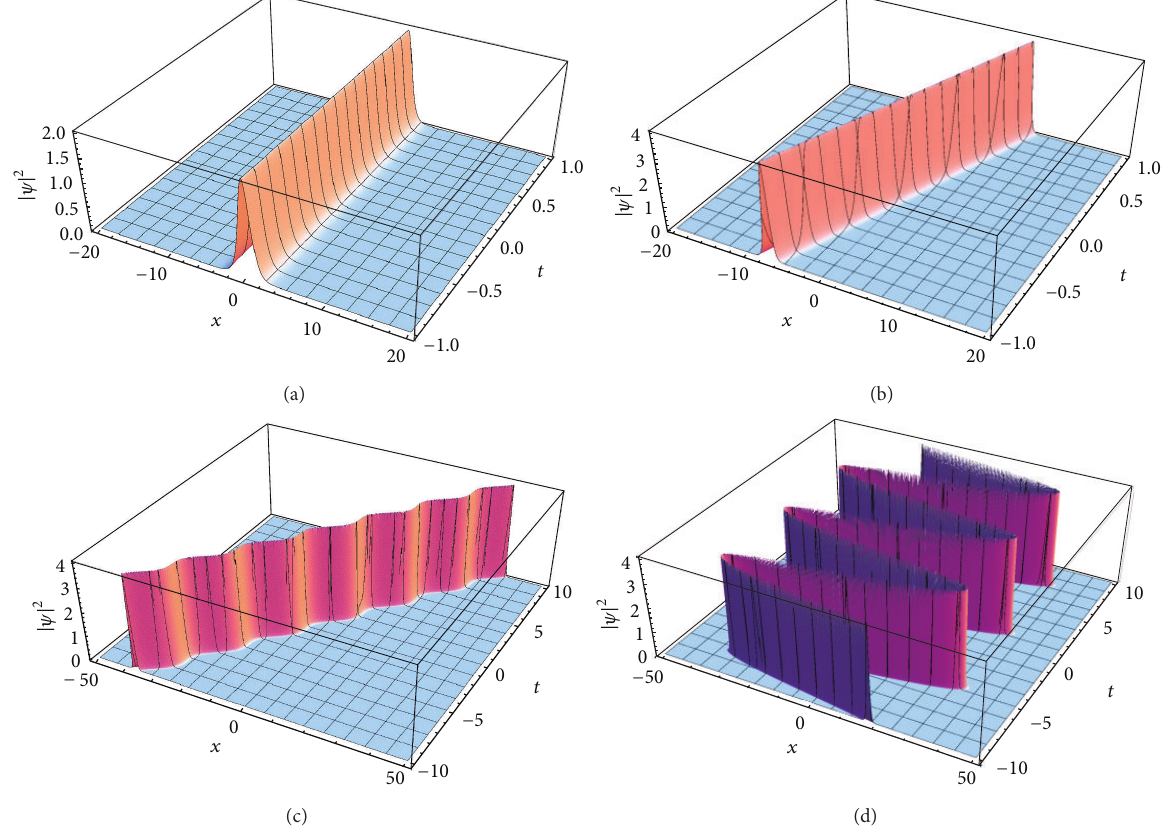
Figure 1: (a) Solitonic solution of NSLE with constant coefficients, 𝑎 1 = 1 and 𝑎 2 = 1 (color online). (b) The solution of (8) with constant coefficients, namely, 𝑎 1 = 1 , 𝑎 2 = 1 , and 𝑎 3 = 0.05 . (c) Trigonometric time dependence for 𝑎 1 = cos (𝑡) , 𝑎 2 = cos (𝑡) , and constant third-order dispersion 𝑎 3 = 0.05 . (d) All the three coefficients are trigonometrically time dependent 𝑎 1 = cos (𝑡) , 𝑎 2 = cos (𝑡) , and 𝑎 3 = 0.05 cos (𝑡)